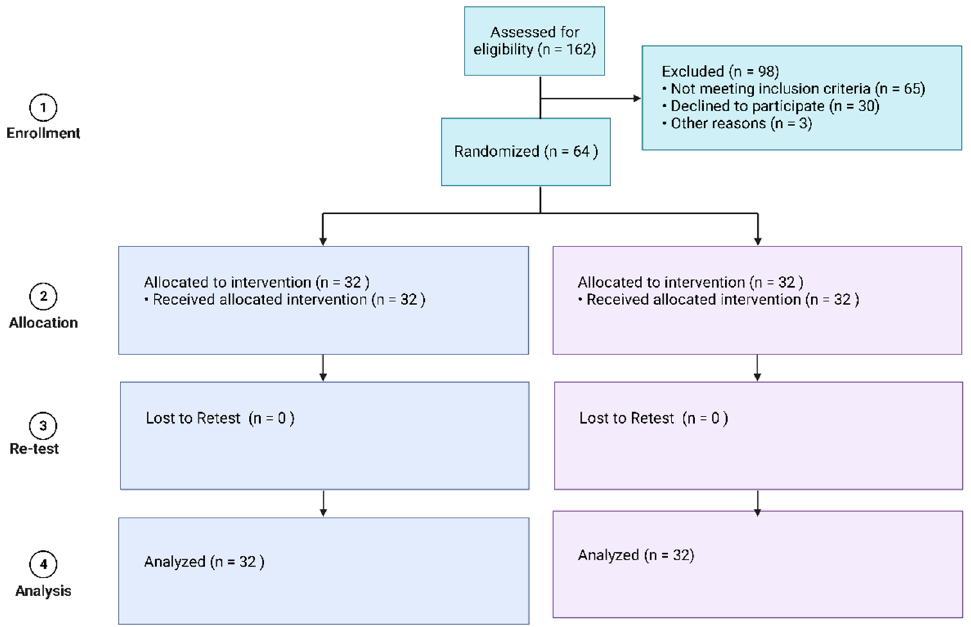
Figure 1. CONSORT diagram.